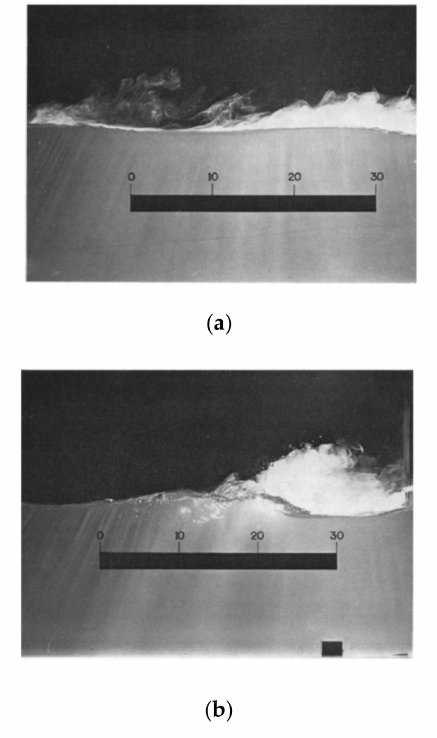
Figure 25. Smoke visualization for the air flow over ( a ) a broken finite amplitude water wave and ( b ) a breaking water wave. The superimposed scale is in cm. The air flow is from left to right with U 0 = 0.9 m / s. Smoke was introduced continuously at the far-right hand side (reproduced from Banner, and Melville